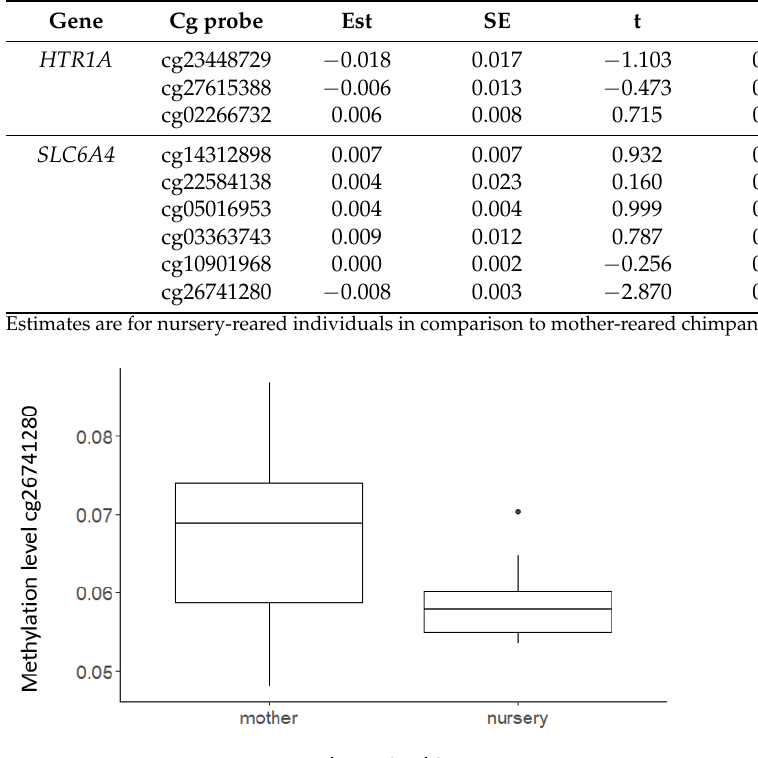
Table 4. Model statistics for rearing effects on methylation rates of personality-related CpG sites.